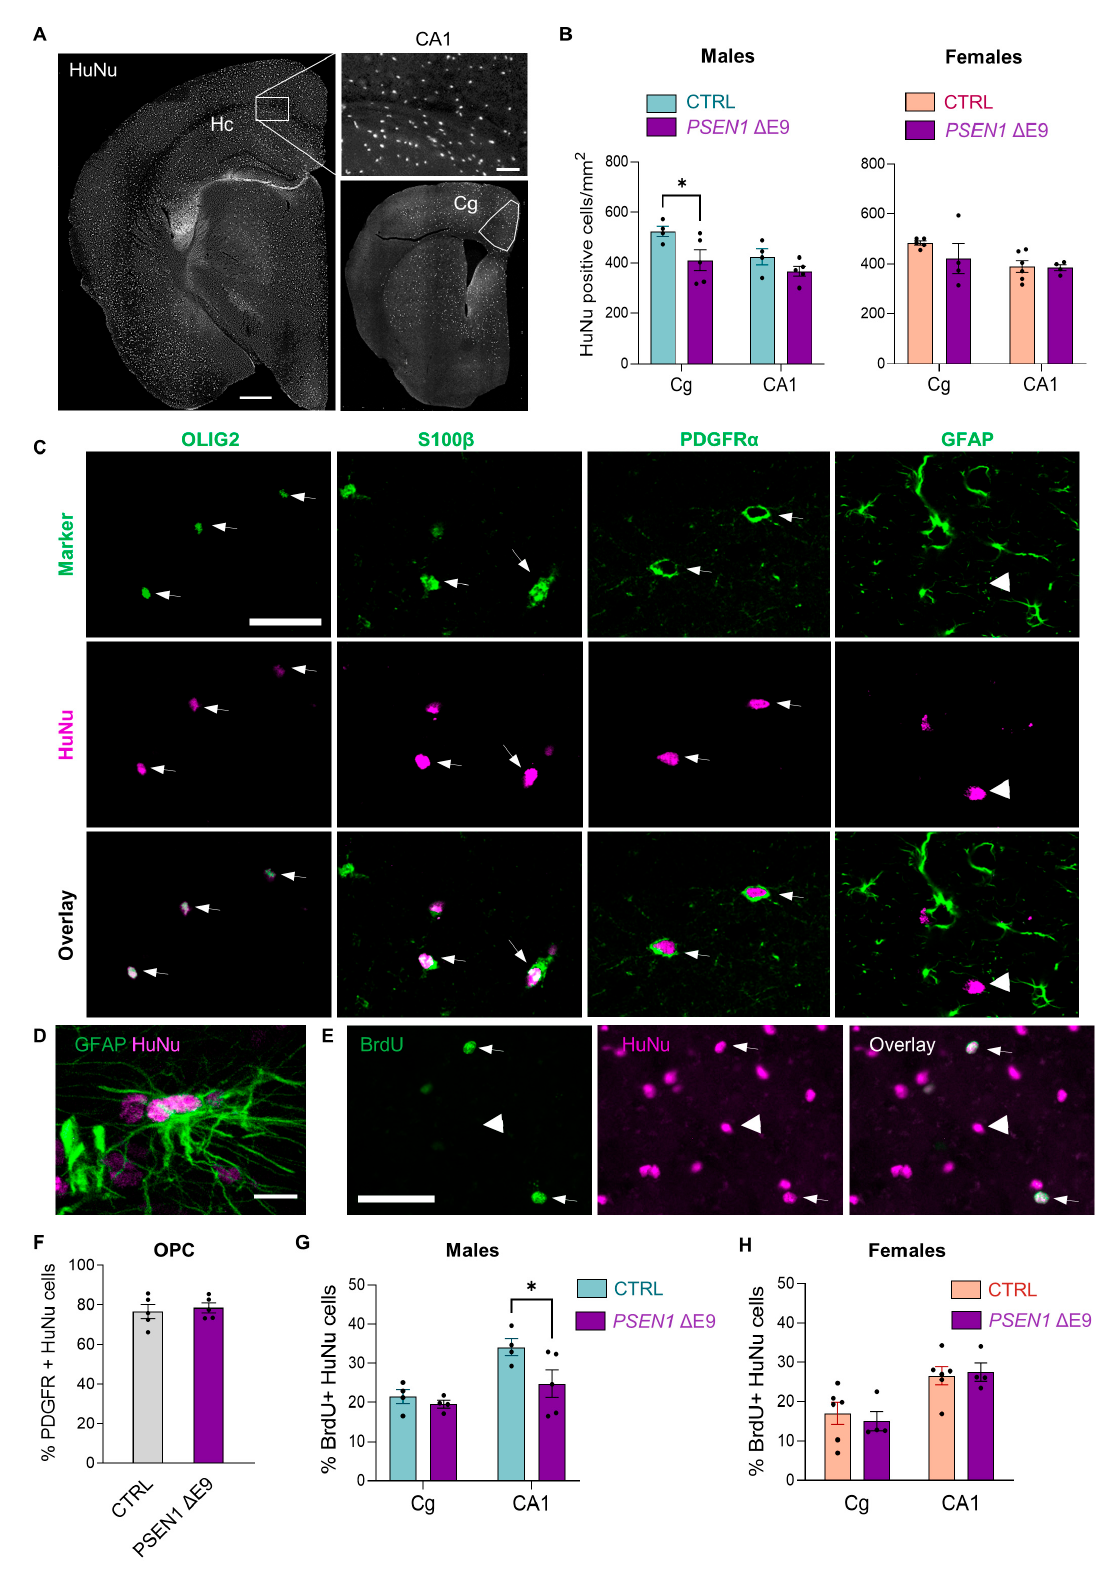
Figure 3. Grafted human progenitor cells survived for 18 months in the mouse brain and gave mostly to OLIG2/PDGFR α -expressing OPCs. ( A ) Representative images of HuNu staining in the mouse